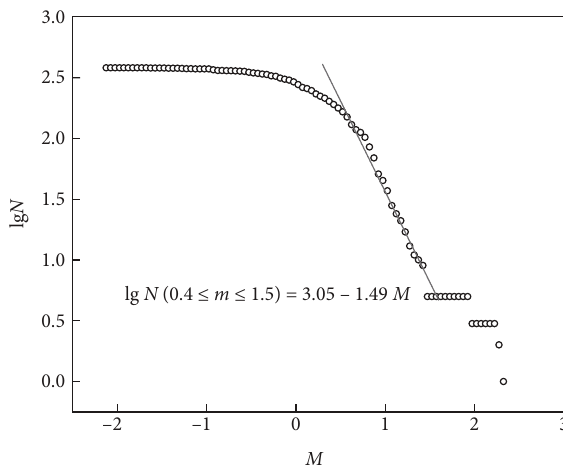
ð r ÞÞ − ln ð r Þ relation curve. Figure 4: ln ð C q